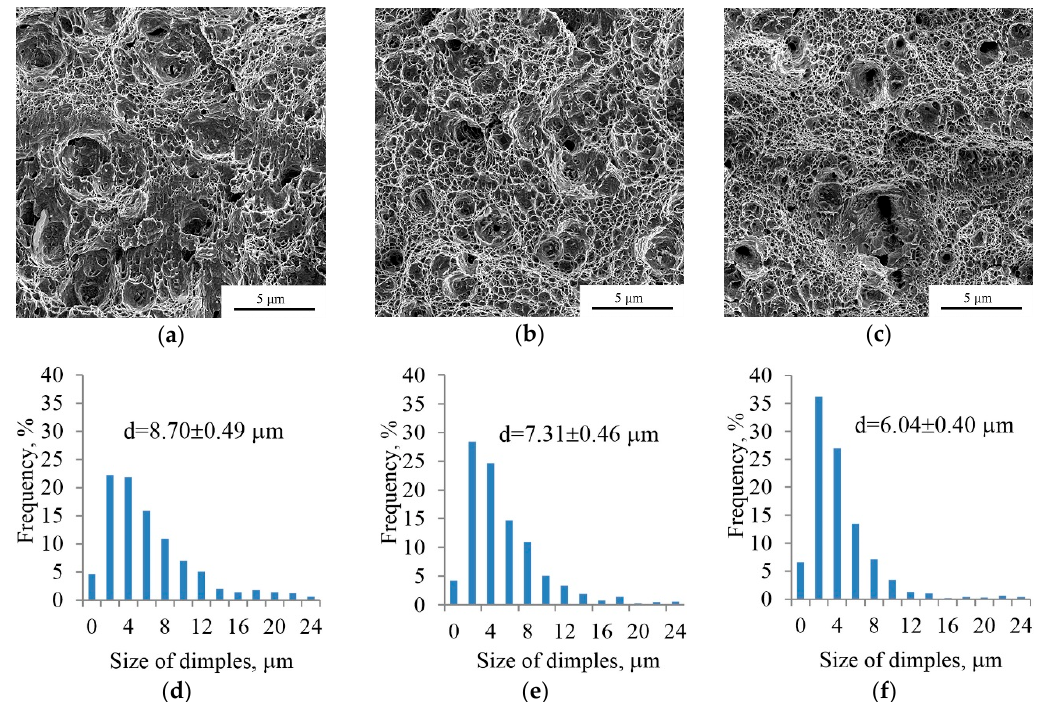
Figure 8. ( a – c ) SEM micrographs the fracture surface after the impact strength testing on KCT 321 MASS for ( a ) the initial state; ( b ) after deformation with degrees of e = 0.56; and ( c ) e = 2.14. ( d – f ) Distribution histograms of the size of the ductile fracture dimples of the fracture surface after the impact strength testing on KCT 321 MASS for ( d ) the initial state; ( e ) after deformation with degrees of e = 0.56; and ( f ) e = 2.14. Note: d is the average size of the ductile fracture dimples.